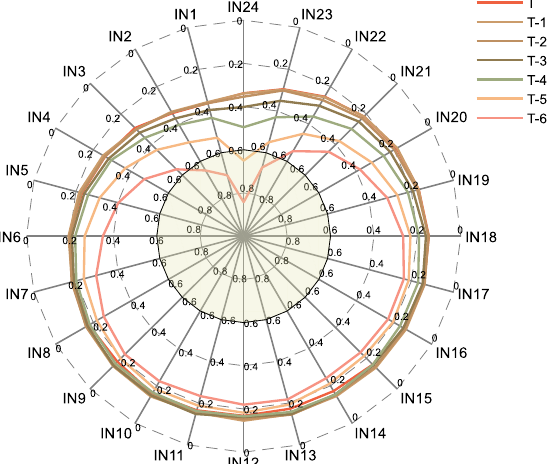
Figure 8. MIC of historical load for dataset 3.